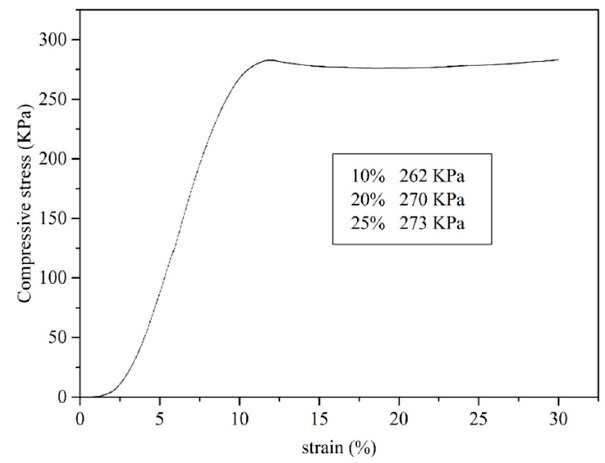
Figure 9. Stress-strain curve of the prepared RPU foam.